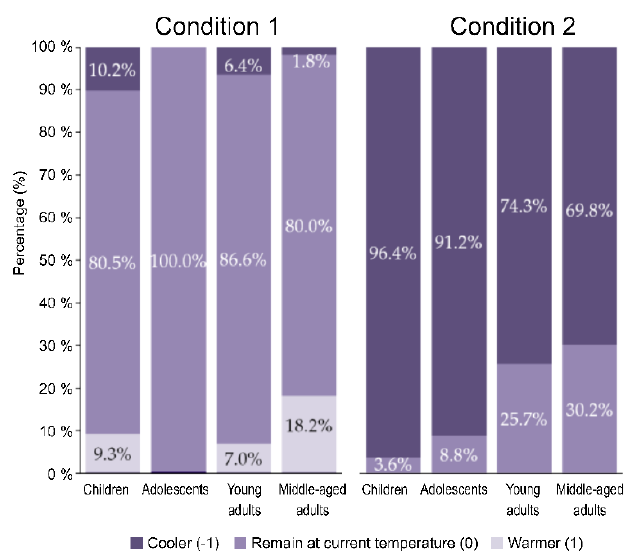
Figure 13. Frequency distribution of thermal expectation votes for the participants in different conditions.